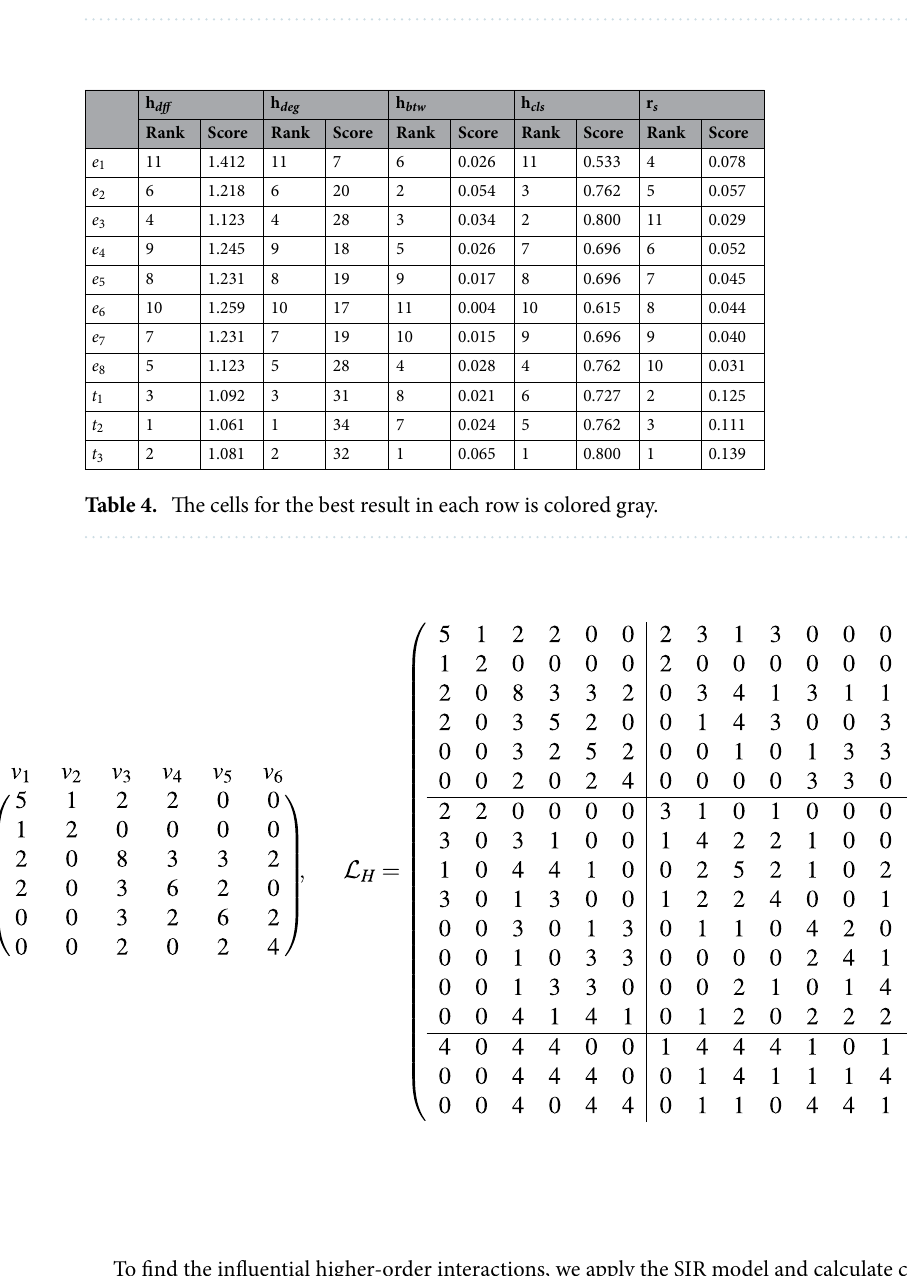
Figure 4. A hypergraph with six vertices (0-simplices), eight edges (1-simplices) and three triangles (2-simplex).